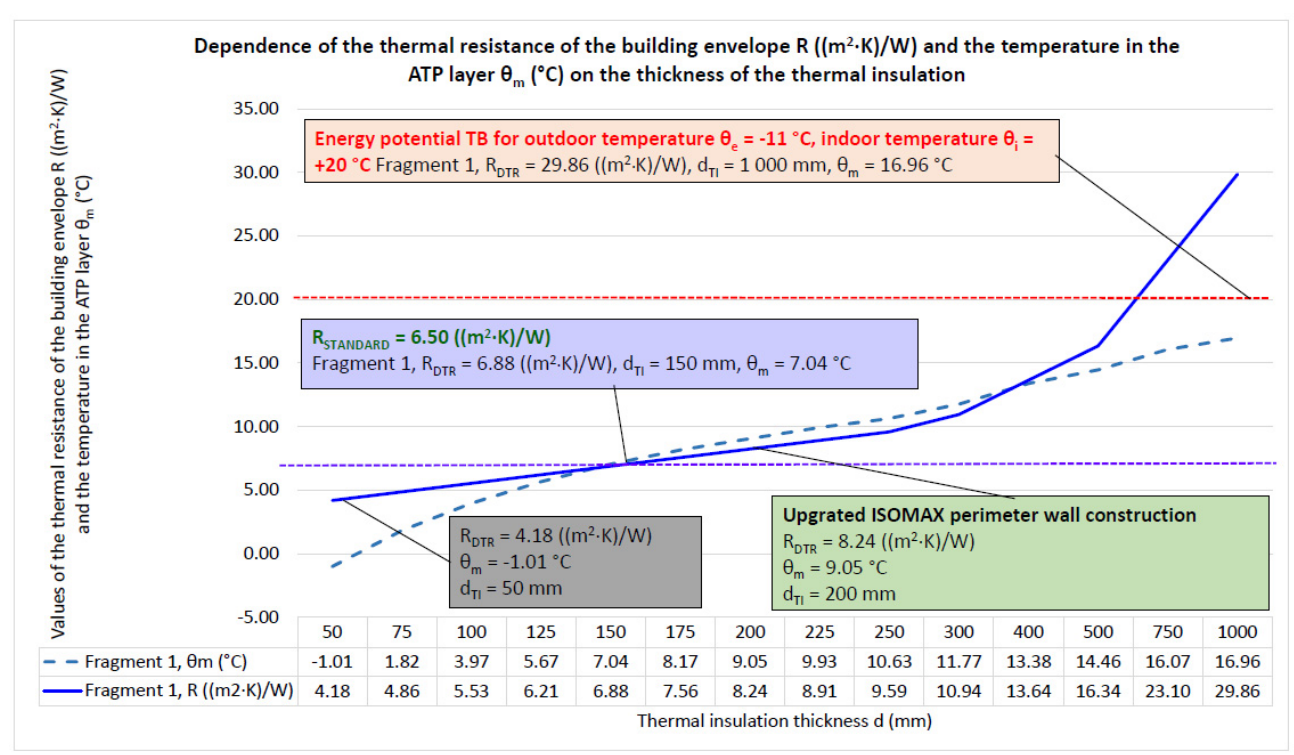
Figure 13. Dynamic thermal resistance as a function of static/dynamic thermal insulation thickness and mean temperature of the heat transfer medium in ATP pipes—Fragment 1.